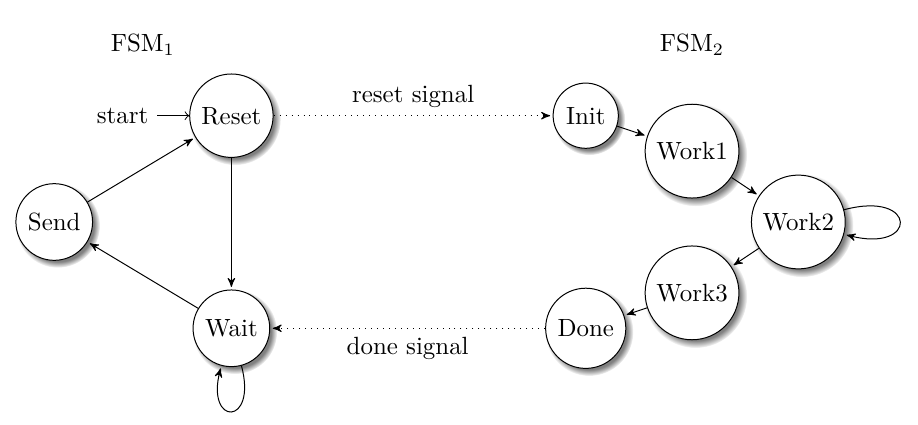
Figure 1: Visualization of two FSMs which can be used as opaque